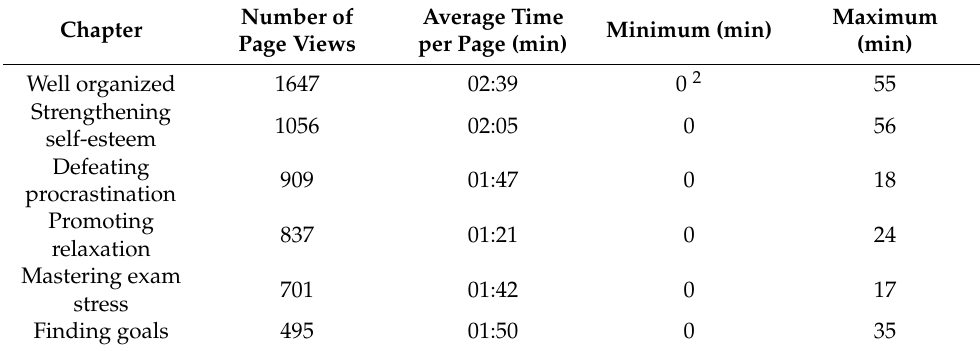
Table 2. (Selected) page views of the chapters of me@JGU website.